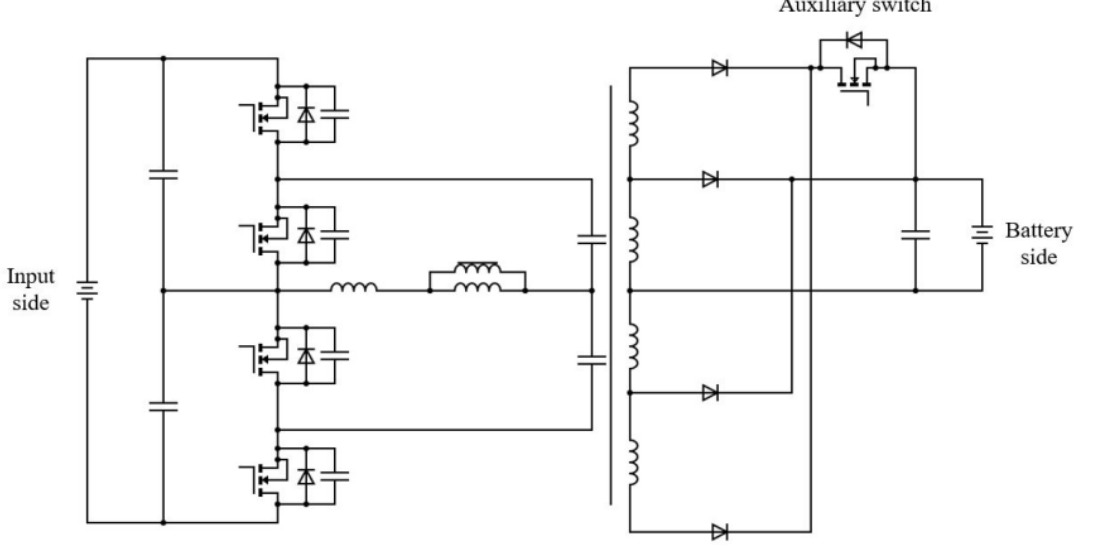
Figure 15. LLC converter for LEV charging [16].